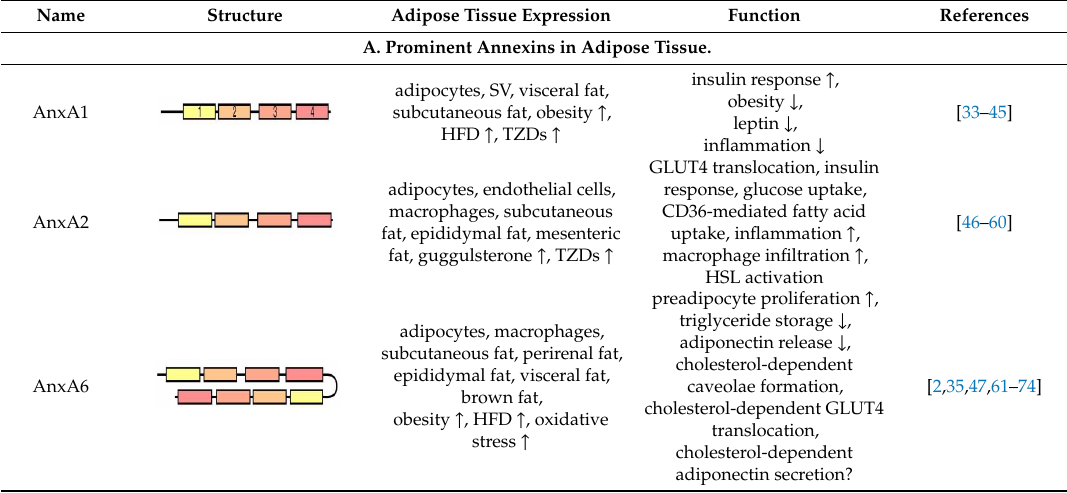
Table 1. Domain structure, expression patterns, and potential functions of annexins expressed in adipose tissue. The different length of the N-terminal leader and C-terminal annexin repeats 1–4 (1–8 for AnxA6) for each annexin are indicated. AnxA13a differs from AnxA13b by a 41 amino acid N-terminal deletion [32]. Relevant references for each annexin are listed. AnxA, annexin; GLUT4, glucose transporter type 4; HFD, high-fat diet; HSL, hormone-sensitive lipase; SV, stromal-vascular fraction; TZDs, thiazolidinediones. N/A, not available.